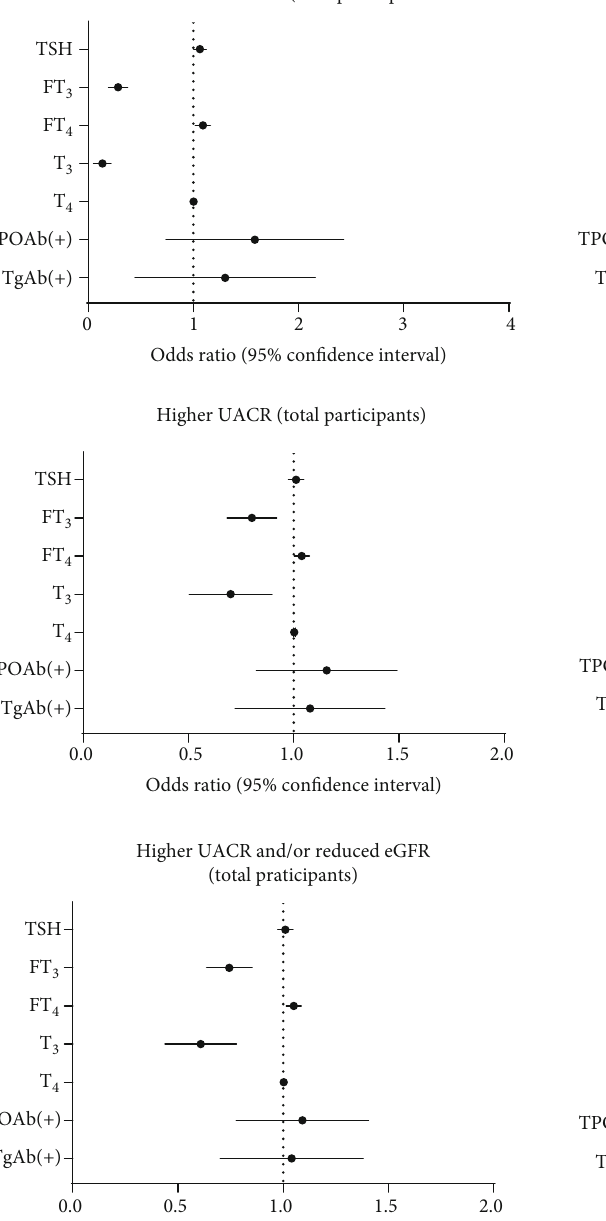
Figure 3: Associations of thyroid hormones and antibodies with reduced eGFR, higher UACR, and higher UACR and/or reduced eGFR. They were analyzed by using logistic regression. The regression models were adjusted for age, sex, HbA1c, BMI, UA, the duration of diabetes, current smoking, dyslipidemia, hypertension, and current use of